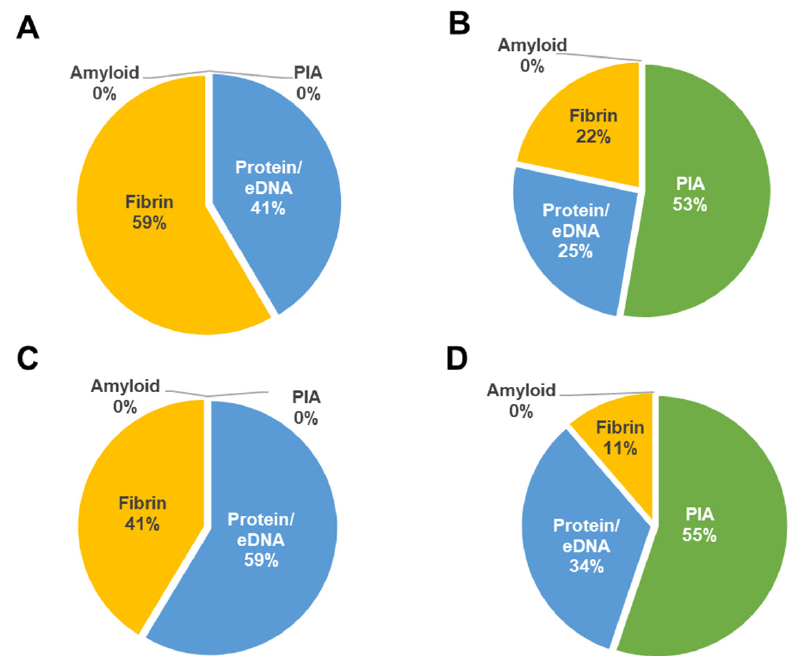
Figure 2. RNAseq-based percentage upregulation of the different mechanisms involved in biofilm formation in studied S. aureus isolates. ( A ) CBS2016-05, ( B ) CI/BAC/25/13/W, ( C ) PS/BAC/169/17/W, and ( D ) PS/BAC/317/16/W. RNAseq data was obtained from the strains grown in PCs and in TSB. The percentages were deduced from the calculated values of the number of genes with enhanced expression in PCs compared to TSB out of the sum of the known genes involved in each biofilm formation mechanism.